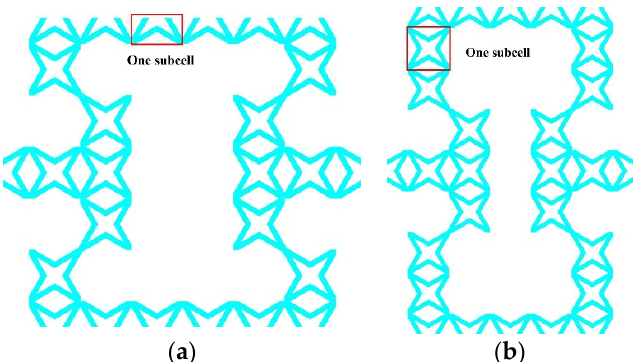
N along y N along y